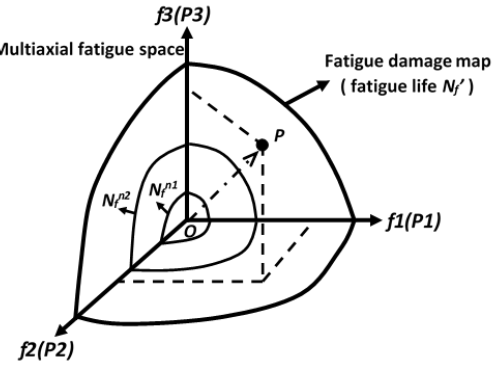
Figure 4. Multiaxial fatigue space.